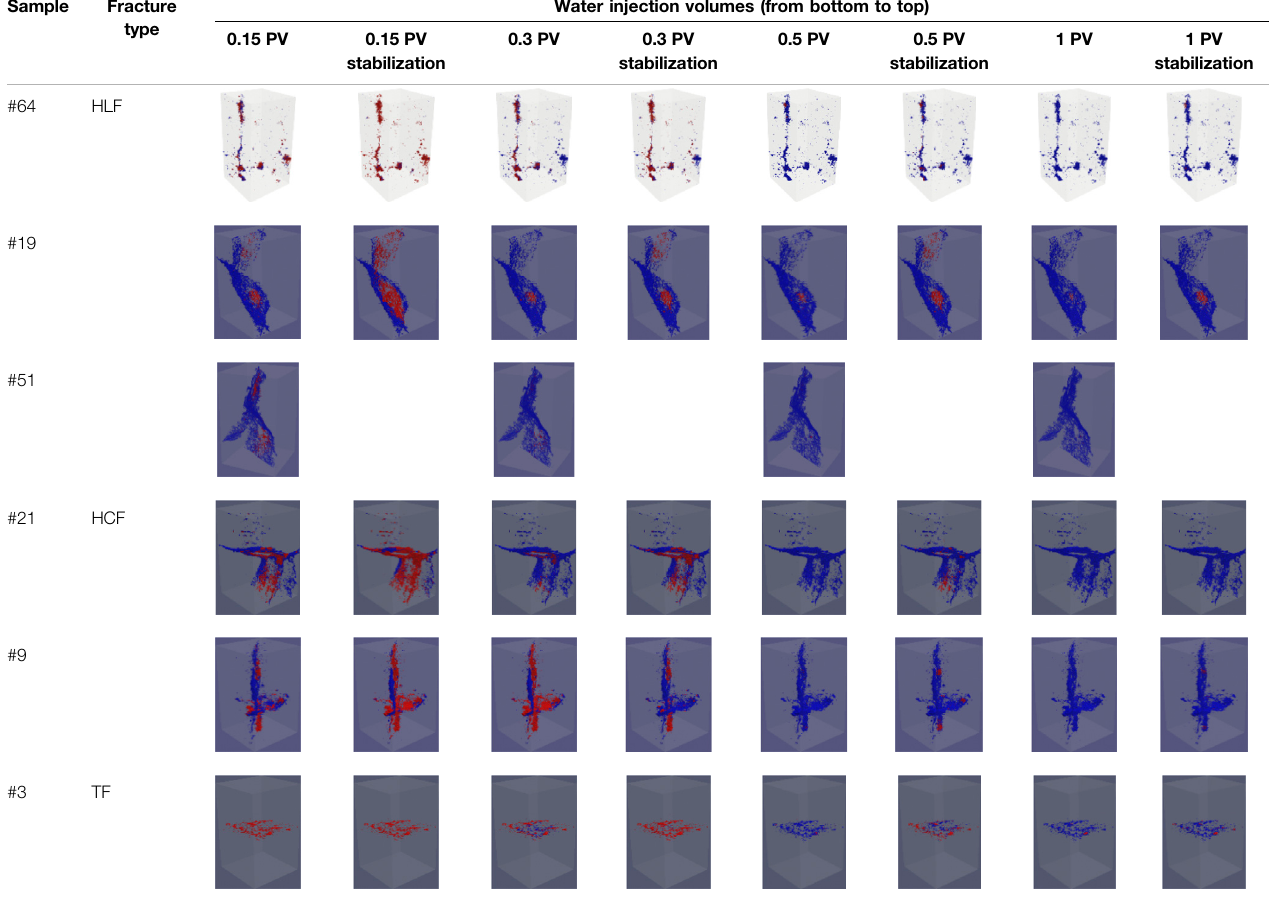
TABLE 5 | Statistics on the percentage of different pore diameter distribution before cracking.